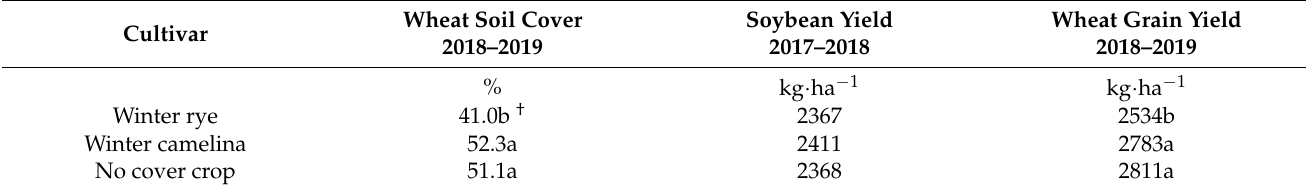
Table 12. Mean soybean yield for two cover crops averaged across five environments in Fargo and Casselton, ND, 2017 and 2018, and mean wheat soil cover and yield across four environments in Fargo, ND, 2018 and 2019. Wheat Soil Cover Cultivar